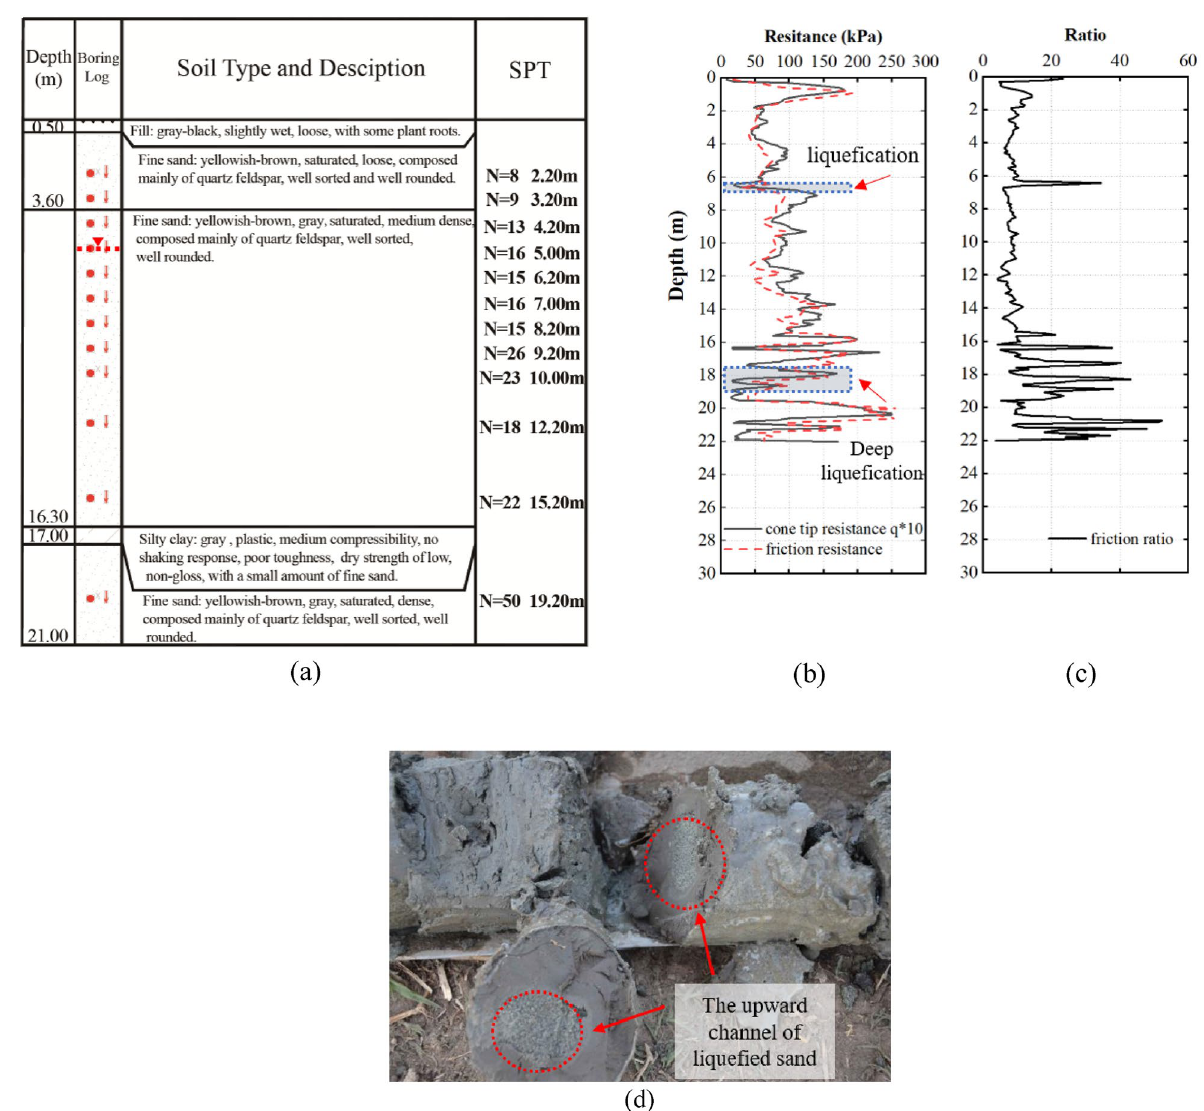
Figure 10. Soil profile ( a ), standard penetration test analysis ( b ), and cone penetration test analysis ( c ) of soil collected at non-liquefaction site. In addition, deep layer liquefaction ( d ) was observed at the